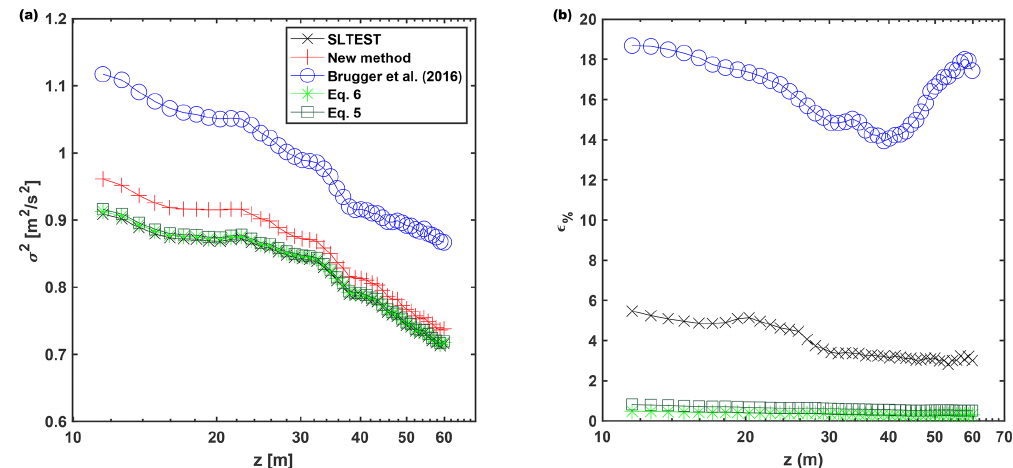
Figure 12. Correction of the streamwise velocity variance with different methods for the SLTEST dataset: (a) streamwise velocity variance and (b) percentage correction of the velocity variance, (cid:15) % . The marker colors are black for the raw lidar data, red for the proposed method, light green for Eq. (6), dark green for Eq. (5), and blue for the method proposed by Brugger et al.